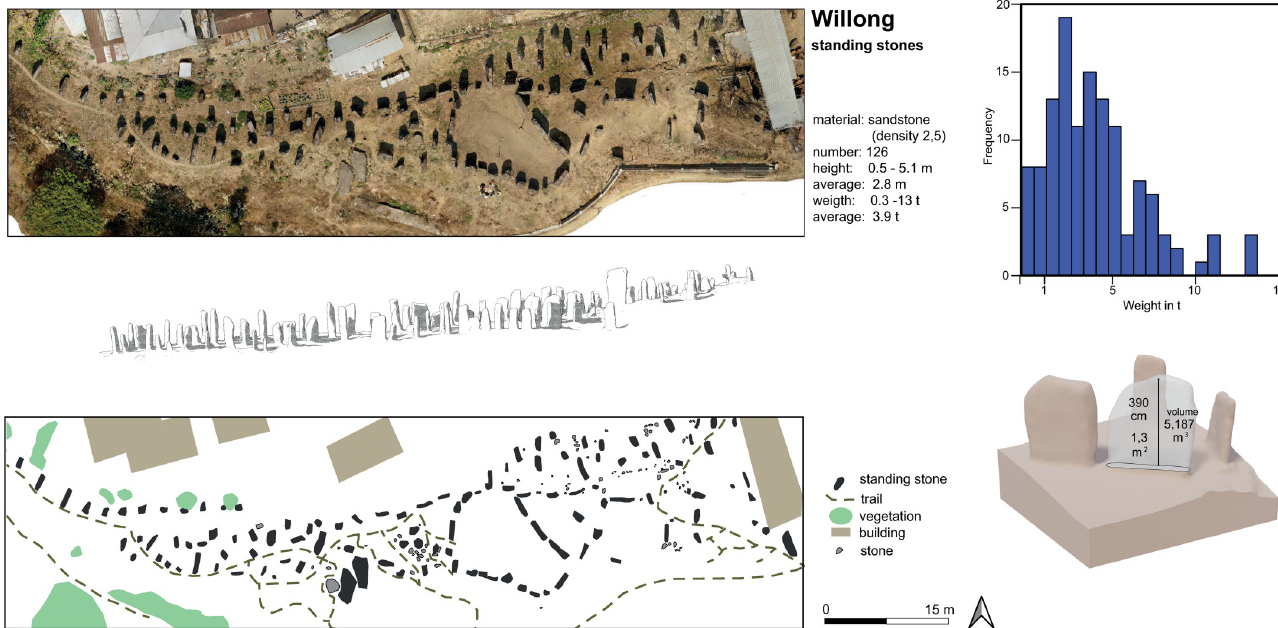
Fig 2. Willong, Manipur. Structure from Motion (SfM) based map and quantitative data (volume, weight) on the standing stones (Data provisioning and graphic: RGK Frankfurt).